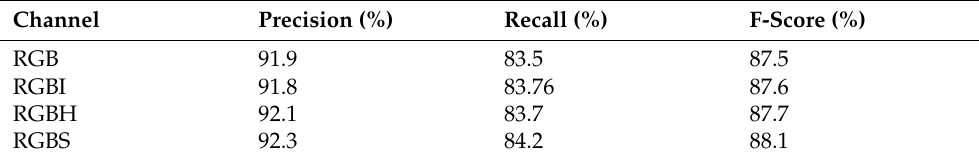
Table 1. NSSS dataset combined with DBNet text detection results in different channel combina- tions.